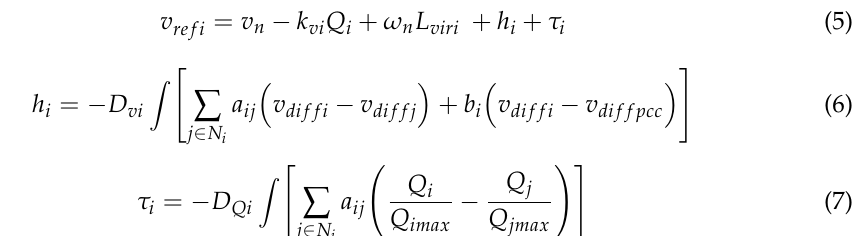
(cid:113) (cid:0) (cid:1) 2 + (cid:0) (cid:1) 2 v pccD v pccQ Figure 1. v pcc = is the voltage at PCC. The subscripts d and q ( D and Q ) indicate the direct and quadrant component in the local (common) reference